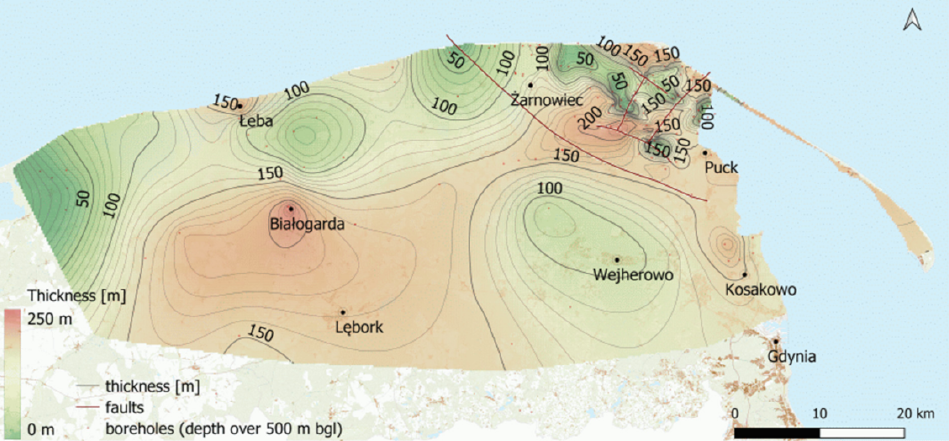
Figure A1. The thickness map of the oldest rock salt (Na1) layer based on the thickness